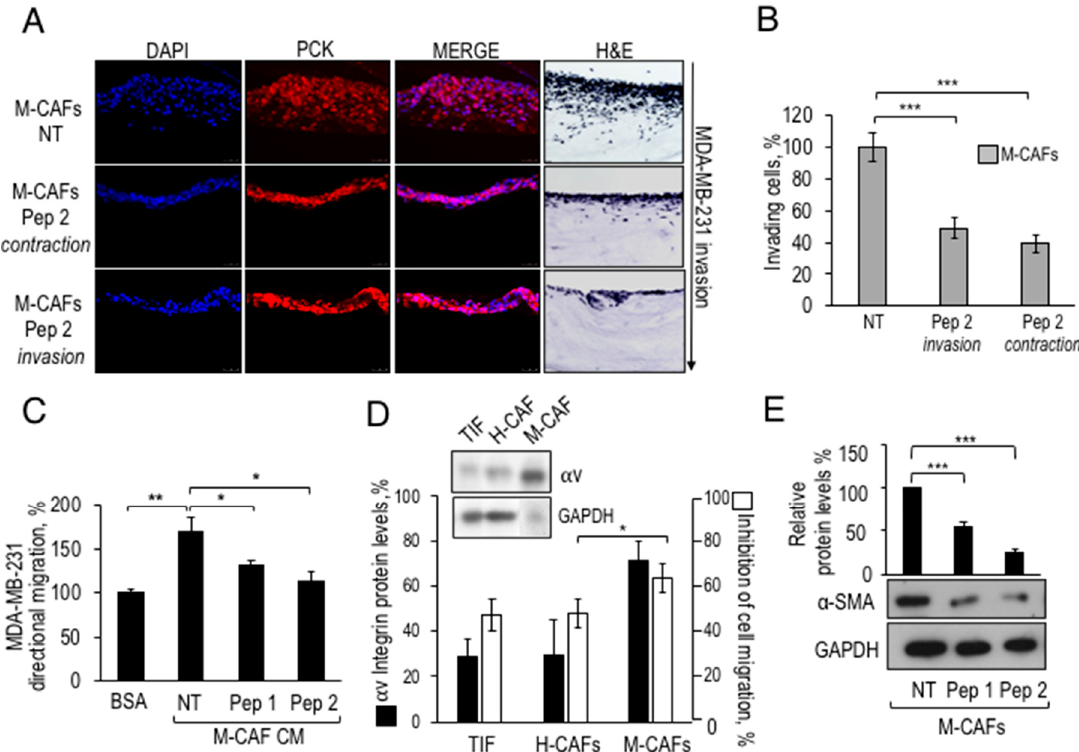
Figure 7. Inhibition of primary breast CAFs pro-invasive activity by Pep 2. ( A ) Organotypic assay with 5 × 10 4 M-CAFs, pre-exposed for 1 h at 37 ◦ C to 100 nM Pep 2 or diluents in DMEM-10% FBS, mixed with neutralized collagen I. The assay includes either diluents (NT), or 100 nM Pep 2 either during contraction (Pep 2 contraction) or invasion (Pep 2 invasion). Treatment during matrix contraction was for 3 days / week, for 2 weeks and then the peptide was excluded from subsequent invasion. Then, 1 × 10 5 MDA-MB-231 cells were seeded on top of matrices for three days. The invasion assay was performed in the presence (Pep 2 invasion) or in the absence (Pep 2 contraction) of 100 nM Pep 2, for 6 days. After para ffi n embedding, matrices were DAPI stained and analyzed by immunofluorescence with Anti-Pan-Cytokeratin antibody. ( B ) The number of invading cells was quantified by Image software, the number of MDA-MB-231 invading cells in untreated matrices was considered as 100%. ( C ) 5 × 10 4 M-CAFs were seeded in DMEM-10% FBS and CM were prepared as described in the legend of Figure 3D and employed as chemoattractants for MDA-MB-231 cells in Boyden chamber migration assays. In each sample, 2 × 10 4 MDA-MB-231 cells were tested either toward BSA-0.1% (basal migration) or toward M-CAFs CM. ( D ) Correlation between α v integrin protein levels in TIF, H-CAFs and M-CAFs and their sensitivity to Pep 2-dependent inhibition of cell migration. Inset: Western Blot analysis of α v protein levels in total cellular lysates of TIF, H-CAFs and M-CAFs. Black columns in the histogram show the relative densitometric analysis. White bars represent the % of Pep 2-dependent inhibition of TIFs or H-CAFs or M-CAFs migration. 5 × 10 4 fibroblasts were treated for 1 h with 100 nM Pep 2 or with diluents and tested toward 3% FBS for 3 h at 37 ◦ C. The results are reported as % of cell migration inhibition, relative to the FBS-dependent migration of untreated samples. ( E ) α -SMA protein levels analyzed by Western Blot in CAFs exposed to Pep 1 or Pep 2. 5 × 10 4 M-CAFs were seeded in 6 well plates in DMEM-10% FBS, grown for 24 h, serum-starved for 6 h, and then treated with 100 nM Pep 1 or Pep 2 or diluents in DMEM-10% FBS. Peptides were re-added to the medium after 24 h and total cellular lysates were prepared after 48 h. Densitometric analysis of Western Blot is shown on top. * p < 0.05; ** p < 0.005; *** p < 0.001, Student’s t -test. The whole blot images can be found in Figure